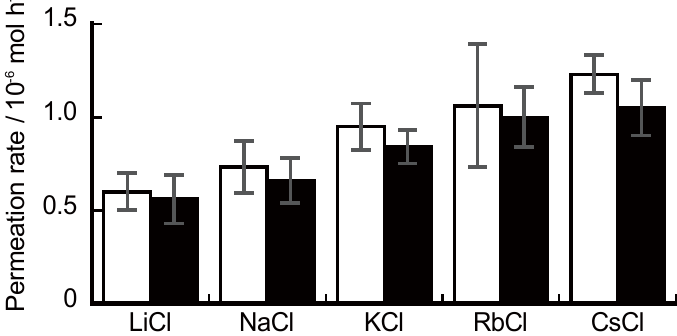
Figure 4. Permeability of alkali chlorides across (PAH-PSS) PAH films (filled column) with a 1 mm diameter. The average values for the (PAH-PSS) 5 three measurements are